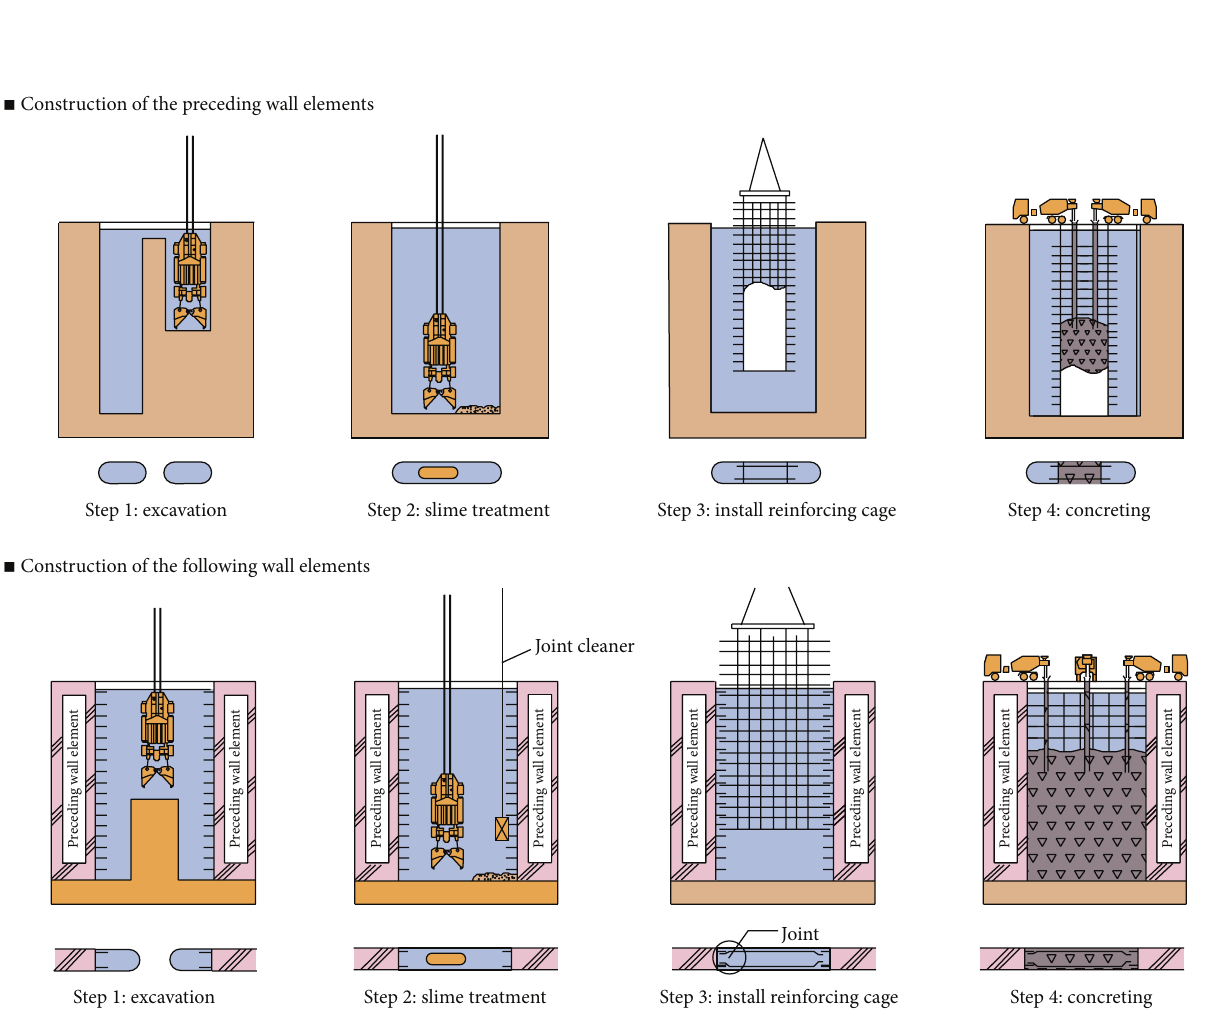
Figure 2: Construction process of wall elements for